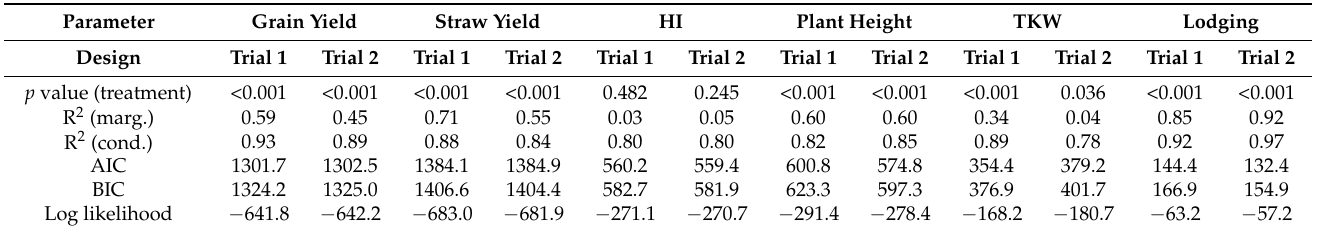
Table 1. Summary data from the linear mixed model ANOVA for agronomic performance traits